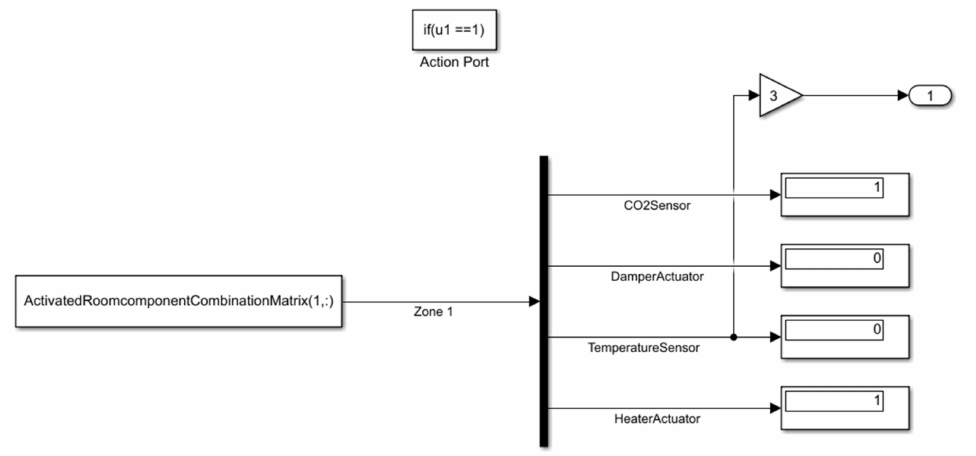
Figure 6. Interior view of faulty targeted component activation.